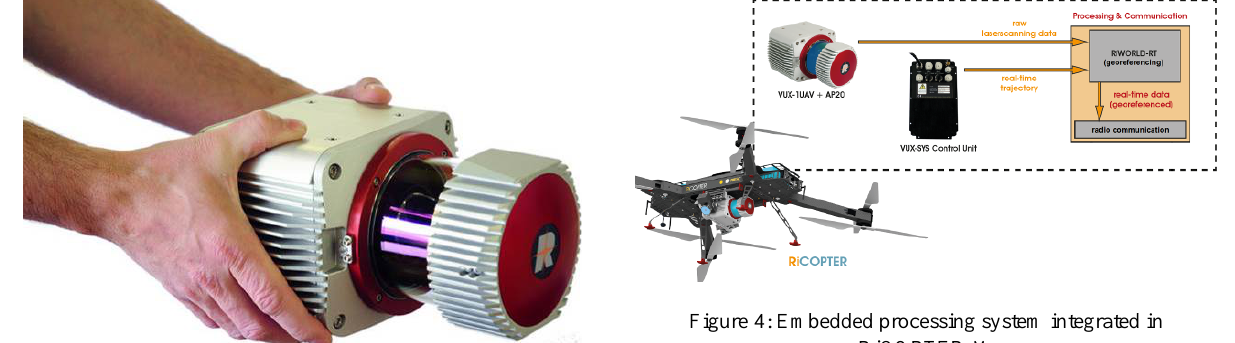
Figure 4: Embedded processing system integrated in